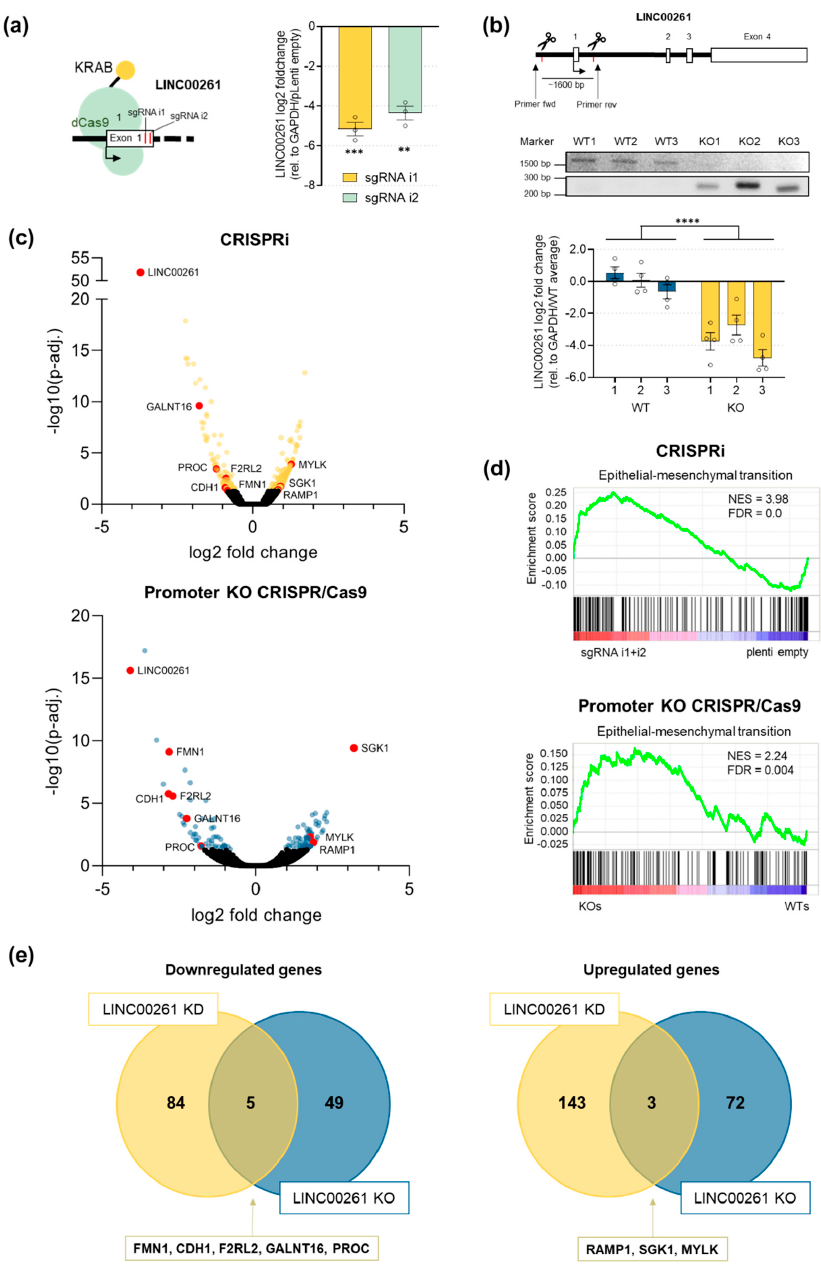
Figure 5. RNA-seq analysis revealed an enrichment of the EMT gene set in LINC00621 low PANC-1 cells. ( a ) Schema of CRISPR interference (CRISPRi)-mediated targeting of LINC00261 and its expression levels in PANC-1 cells measured by qRT-PCR (** p < 0.01, *** p < 0.001, one-way ANOVA). ( b ) Schema of CRISPR/Cas9-mediated knockout of the promoter region of LINC00261 using two sgRNAs. Cutting of both sgRNAs led to the removal of a genomic fragment of ~1600 bp. PCR and gel electrophoresis using the indicated primers resulted in a ~1600 bp product in wild-type clones and a ~250 bp product in knockout clones (**** p < 0.0001, two-way ANOVA). ( c ) Volcano plots of RNA-seq analyses of differently expressed genes of CRISPRi- and CRISPR/Cas9-mediated knockdown of LINC00261. Significantly deregulated genes (adjusted p -value ( p -adj.) < 0.05) are highlighted. Genes found to be deregulated in both cell systems are labelled in red. ( d ) GSEA analysis of RNA sequencing data revealed a significant enrichment of the EMT gene set in LINC00261-depleted cells in both knockdown systems. ( e ) Venn diagrams show the intersection of significantly ( p -adj. < 0.05) downregulated or upregulated genes due to LINC00261 knockdown by CRISPRi or CRISPR / Cas9